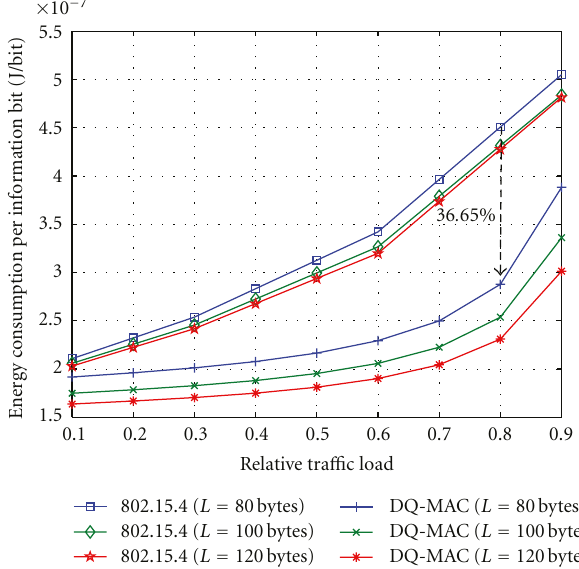
Figure 7: Analytical energy consumption per information bit: DQ versus IEEE 802.15.4